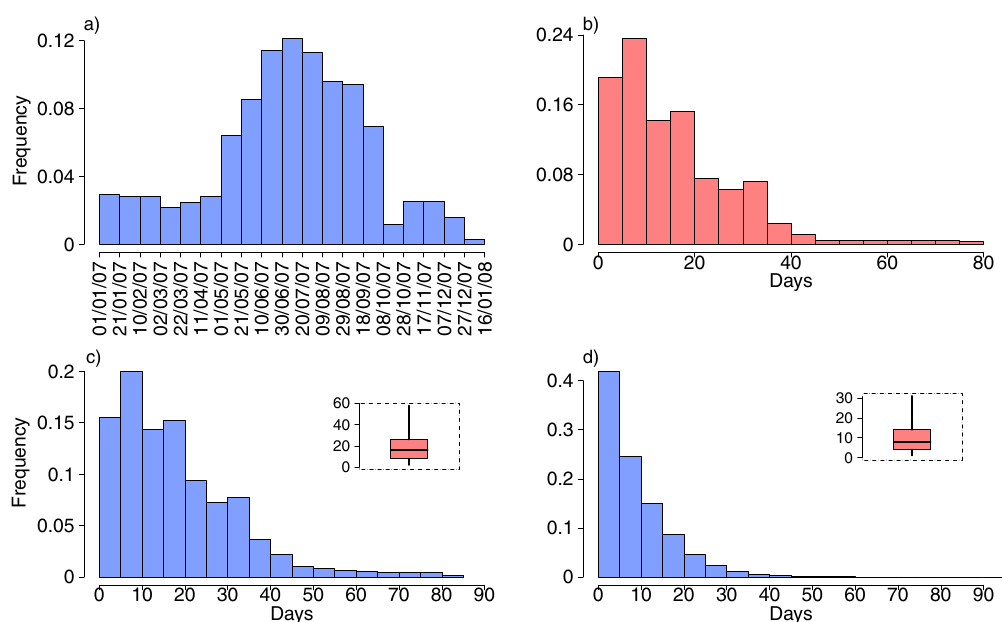
Figure 2. ( a ) Sampling distribution of dates of arrival of CHIKV cases from endemic area 34 . ( b ) Sampling distribution of time elapsed between the arrival and the notification of CHIKV cases to public health authorities 34 . ( c ) Posterior distribution of time elapsed between the arrival of the first case, either symptomatic or asymptomatic, and the first notification to public health authorities. ( d ) Posterior distribution of time elapsed between the observation of the last symptomatic case and the last infected